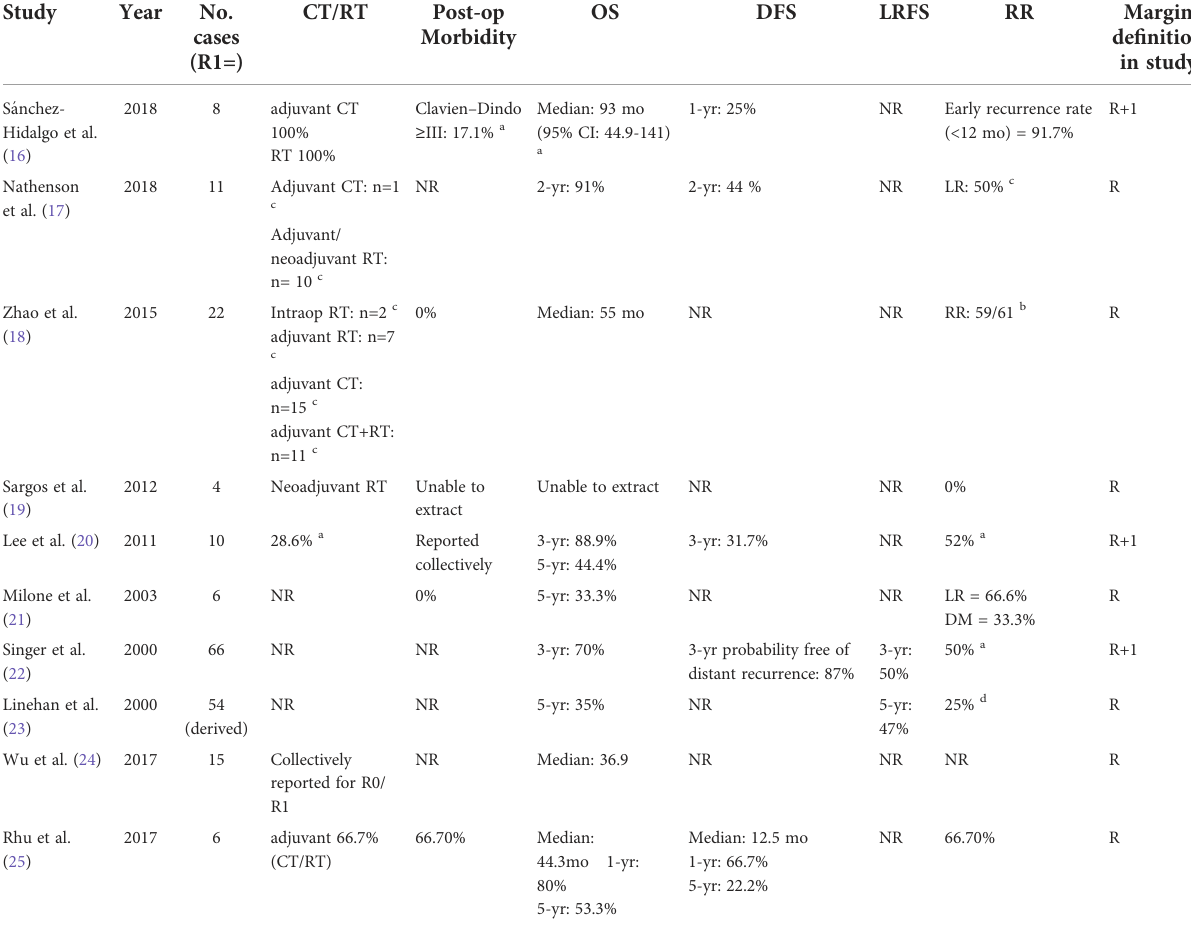
TABLE 2B Summary of cohort studies that included patients receiving R1-margin